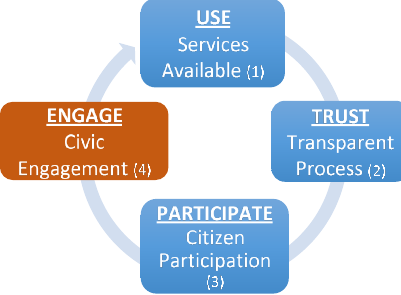
Figure 1. Service based citizens’ engagement: Life Cycle Approach.